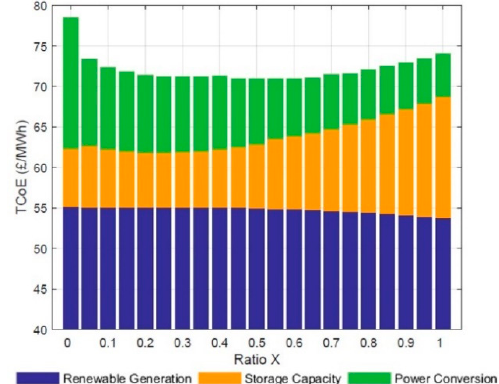
Figure 16. Breakdown of the TCoE achieved by different system configurations.